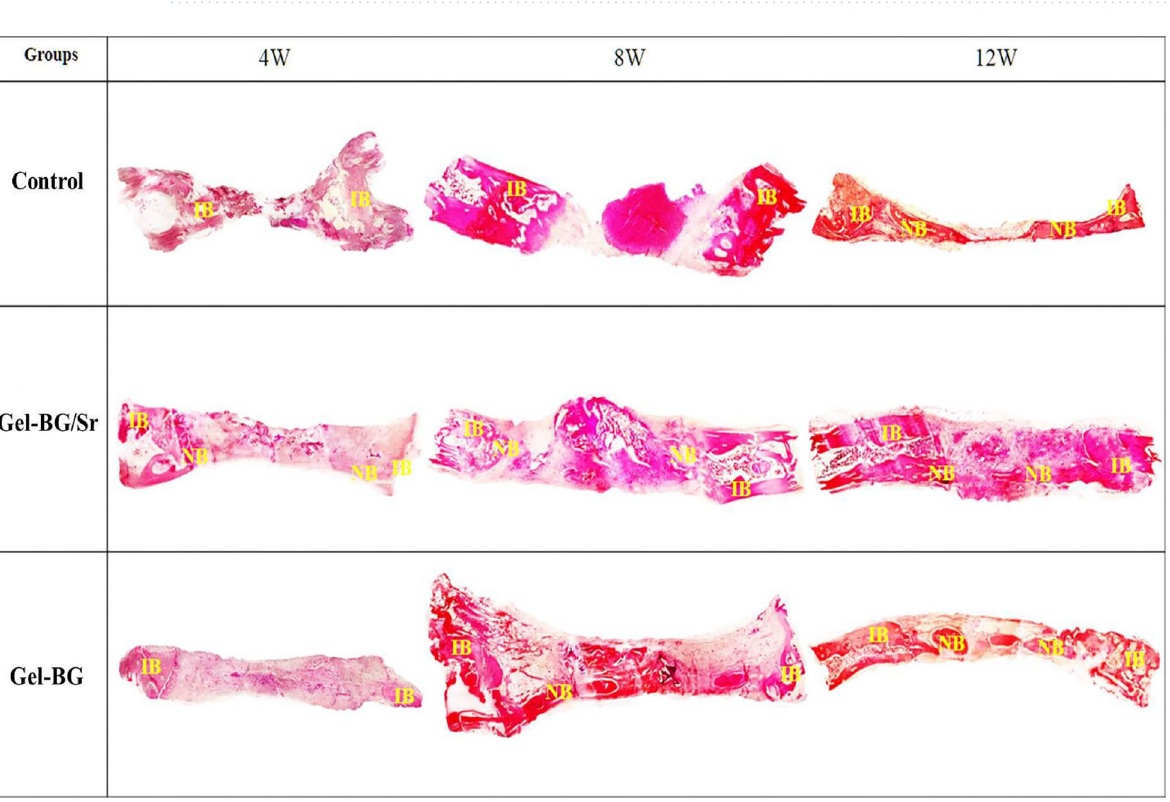
Figure 3. Histological examination (H&E staining) at 4, 8 and 12 weeks. IB (Intact Bone), NB (New Bone) (magnification